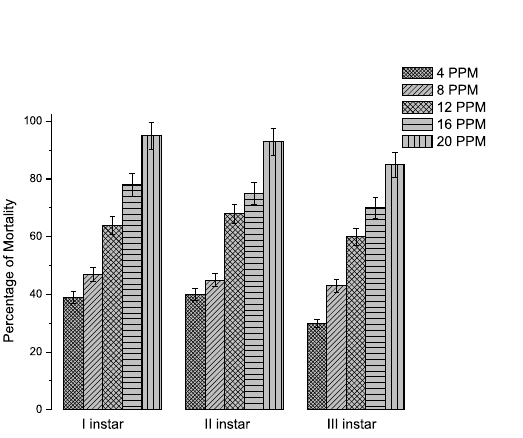
Fig. 7. Ovi position deterrence assay for silver nanoparticle from Caryota urens with different